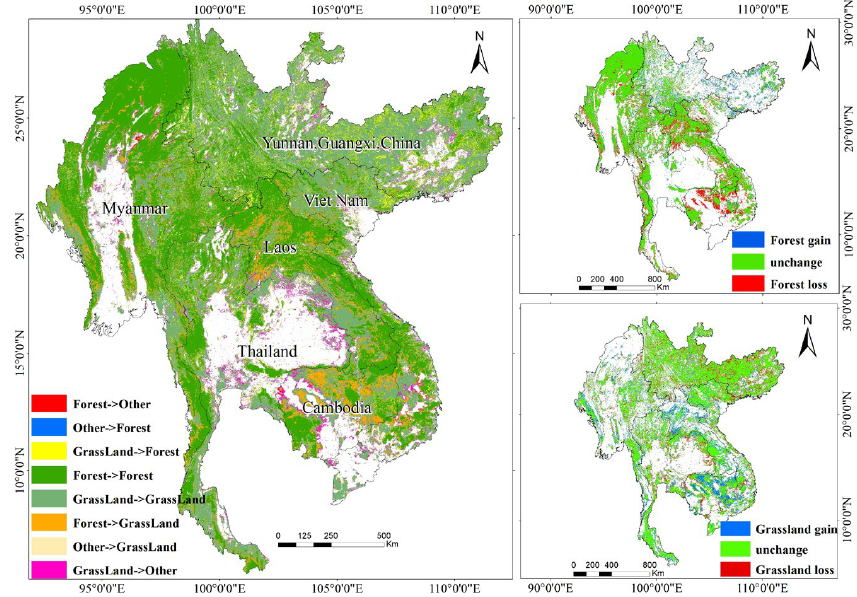
Figure 3. Spatial distribution of land use/land cover (LULC)